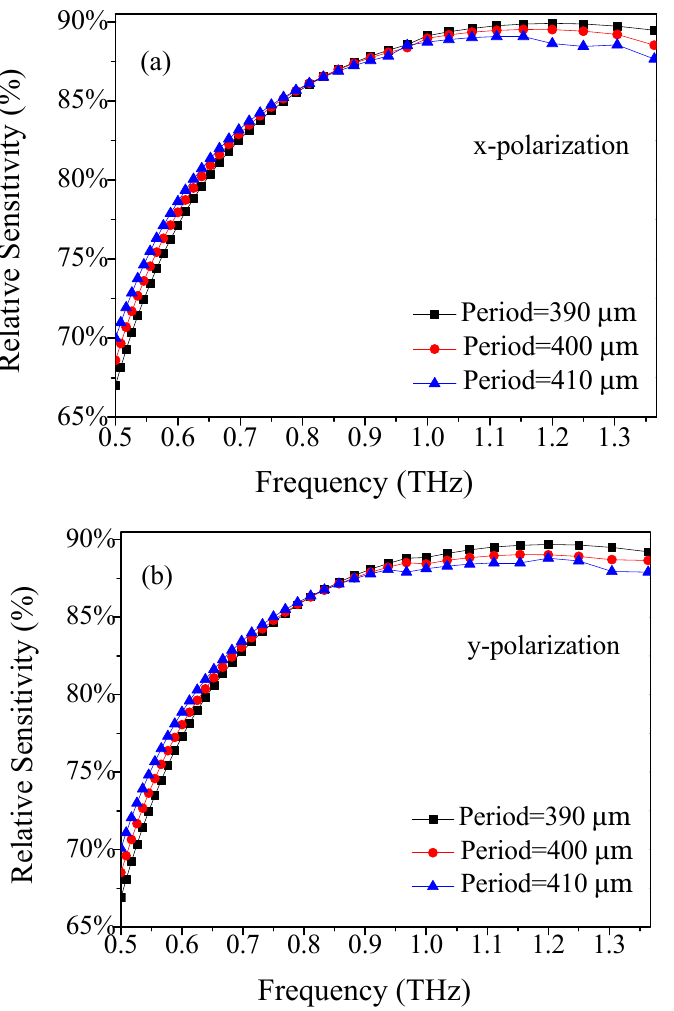
Figure 2. Frequency dependence of the relative sensitivity of ( a ) x- and ( b ) y-polarization for period Λ .